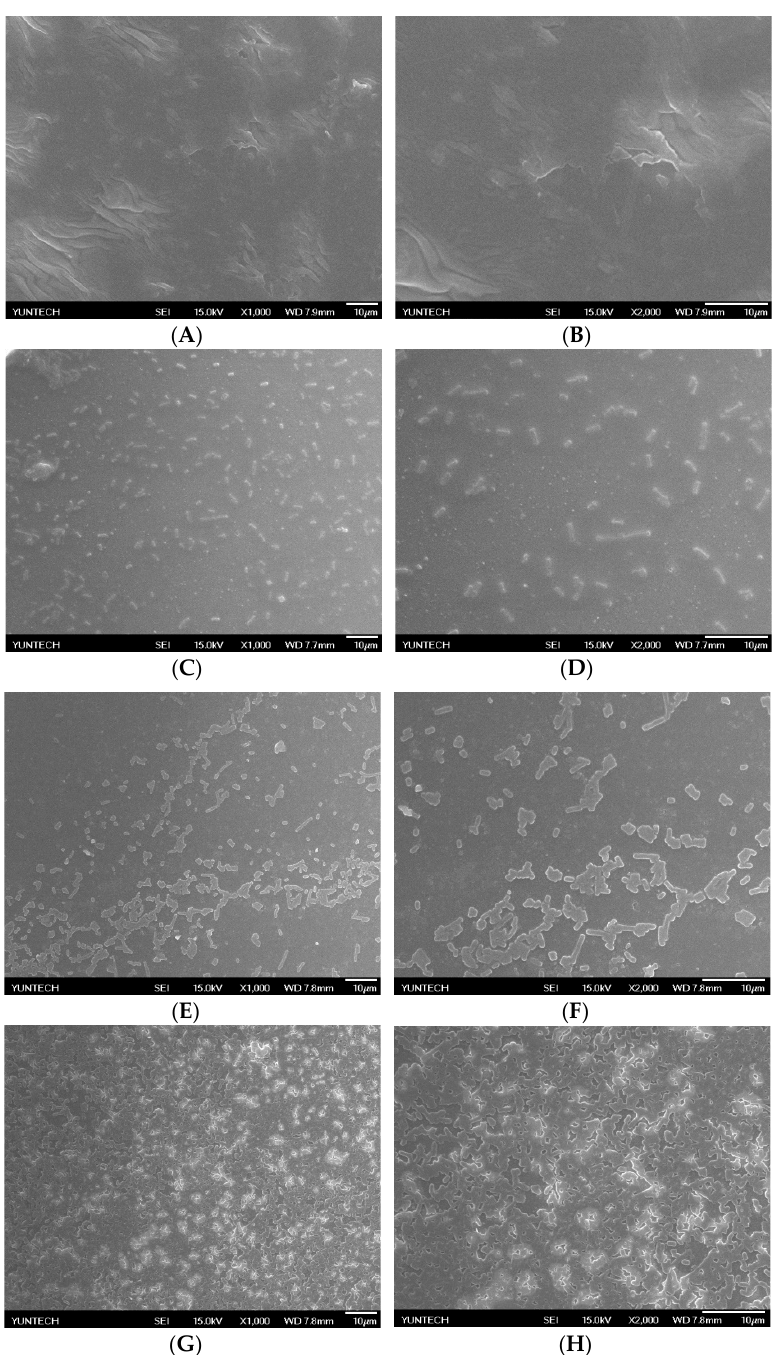
Figure 6. Biofilm formation by L. brevis RK03 on hydrogel films in MRS medium at 30 °C for 60 h. ( A ) Control 0 h, ×1000; ( B ) Control 0 h, ×2000; ( C ) 12 h, ×1000; ( D ) 12 h, ×2000; ( E ) 36 h, ×1000; ( F ) 36 h, ×2000; ( G ) 60 h, ×1000; ( H ) 60 h, ×2000.